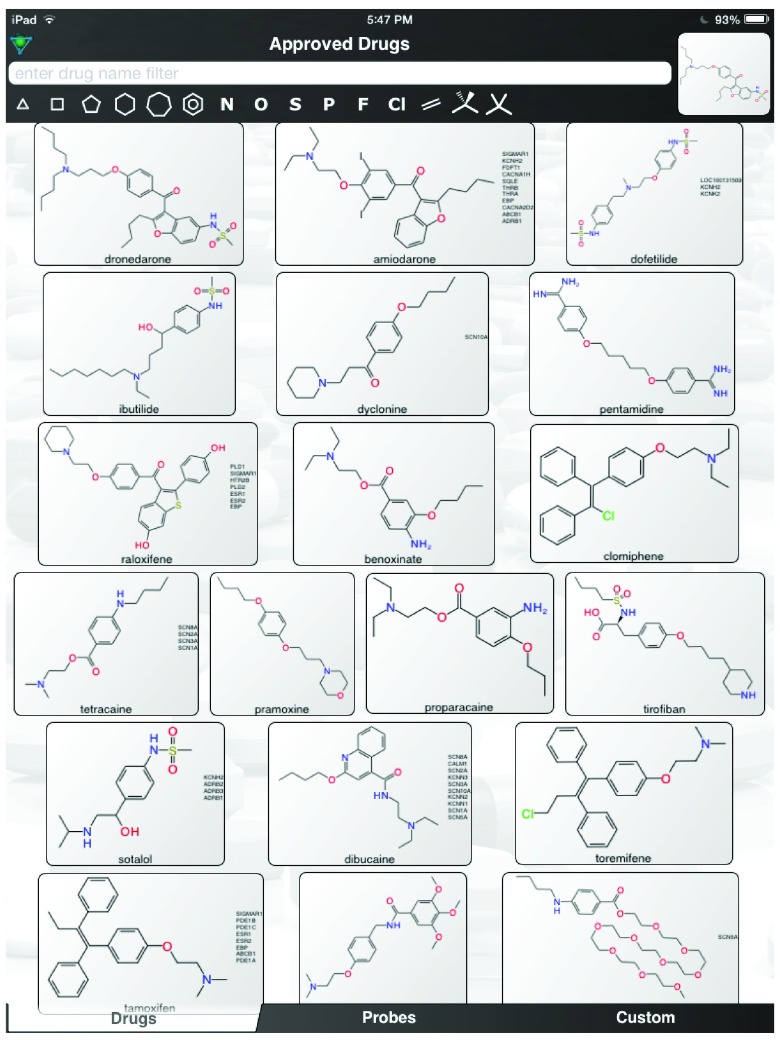
Dronedarone similarity in Approved drugs mobile app
http://molmatinf.com/approveddrugs.html.